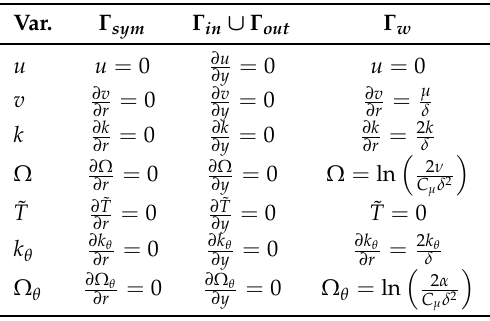
Table 7. Cylindrical pipe tests. Boundary conditions.